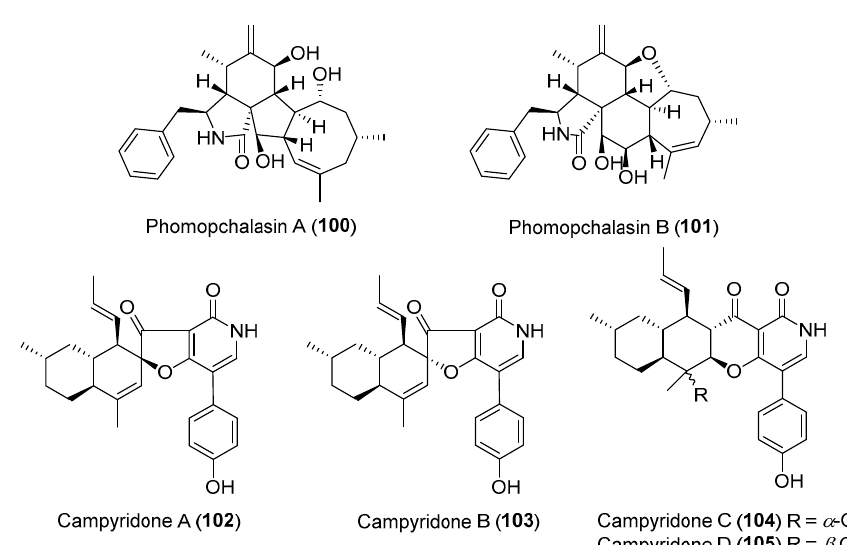
Figure 17. Structures of phomopchalasins A–B ( 100 – 101 ) and campyridones A–D ( 102 – 105 ).